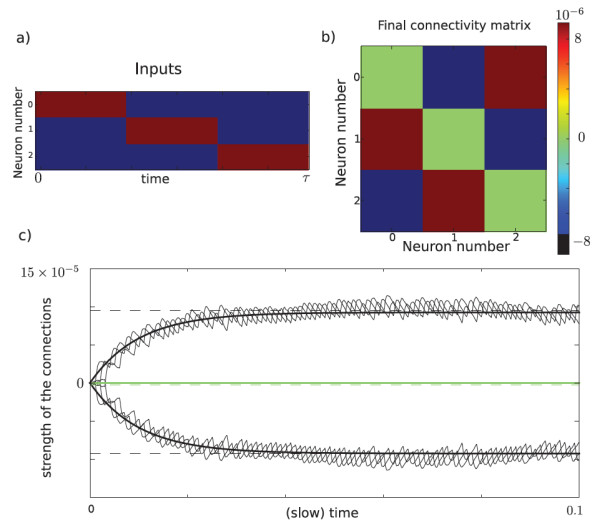
Antisymmetric STDP learning for a network of n=3 neurons. (a) Temporal evolution of the inputs to the network. The three neurons are successively and periodically excited. The red color corresponds to an excitation of 1 and the blue to no excitation. (b) Equilibrium connectivity. The matrix is antisymmetric and shows that neurons excite one of their neighbors and are inhibited by the other. (c) Temporal evolution of the connectivity strength. The colors correspond to those of (b). The connectivity of system (17) corresponds to the plain thin oscillatory curves. The connectivity of the averaged system (18) (with k,q<4) corresponds to the plain thick lines. Note that each curve corresponds to the superposition of three connections which remain equal through learning. The dashed curves correspond to the antisymmetric part in (19). The parameters chosen for this simulation were l=10, κ=100, γ=3, a+=a−=1, τ=3, σ=0.001, μ=1, ϵ=0.001. The system was simulated on the fast time-scale during T=10,000 time steps of size dt=0.01.